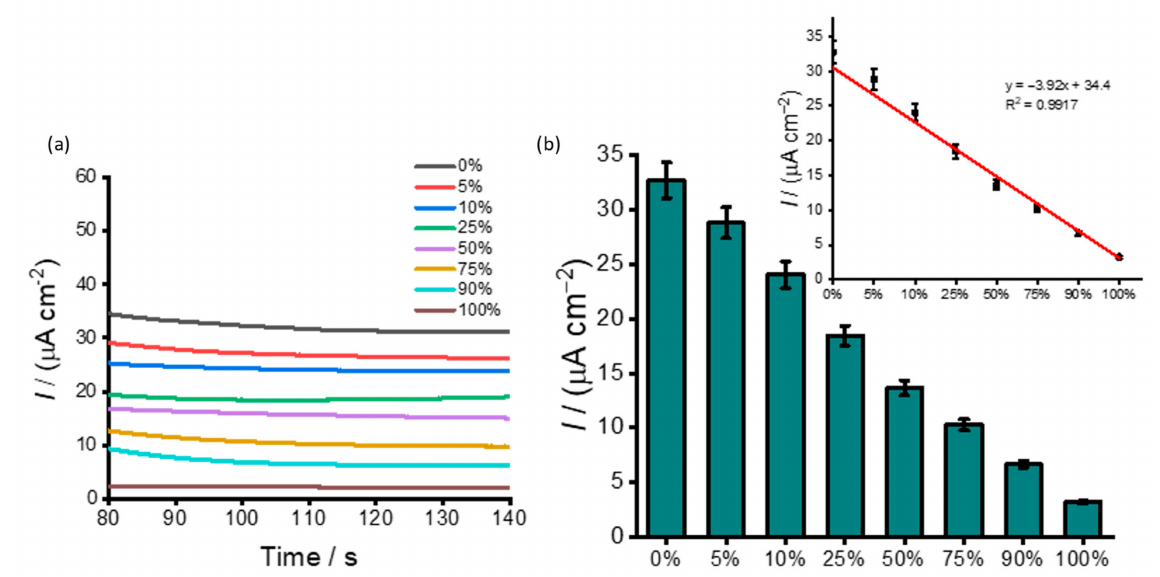
Figure 5. ( a ) Amperometric curves corresponding to different % methylated synthetic oligonucleotides sequences in buffer solution (i.e., samples containing 0%, 5%, 10%, 25%, 50%, 75%, 90%, and 100%); ( b ) their corresponding plots showing the magnitude current density profiles. Each data point represents the average of three repetitive experiments, and error bars represent the standard deviation of measurements (%RSD ≤ 5% for n =